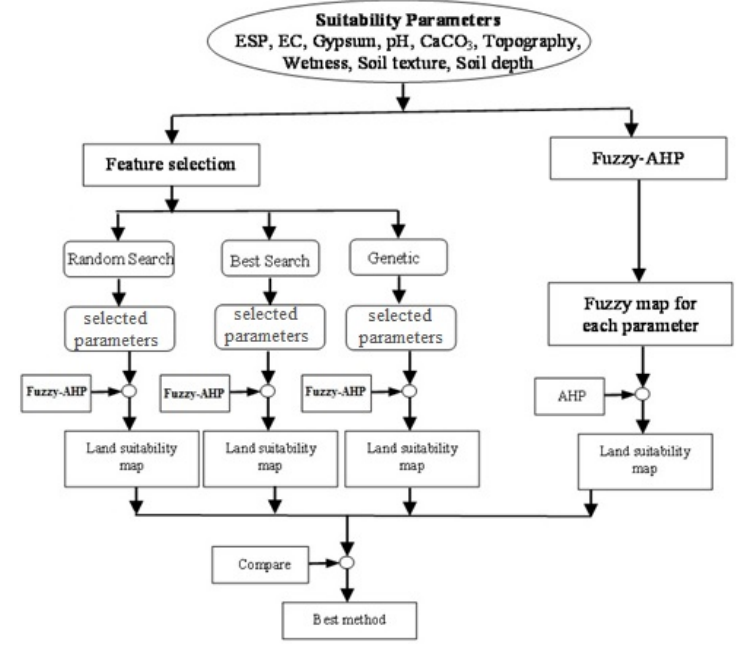
Figure 2. Overview of the methodology.